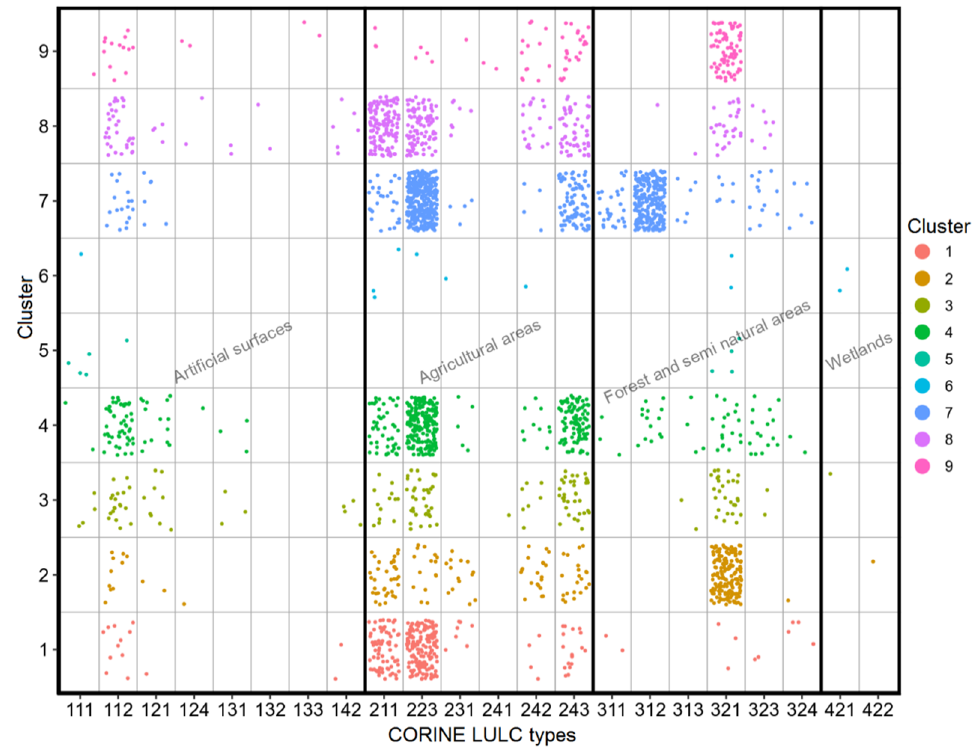
Figure 9. Cross tabulation of clusters and CORINE land-use/land-cover types.